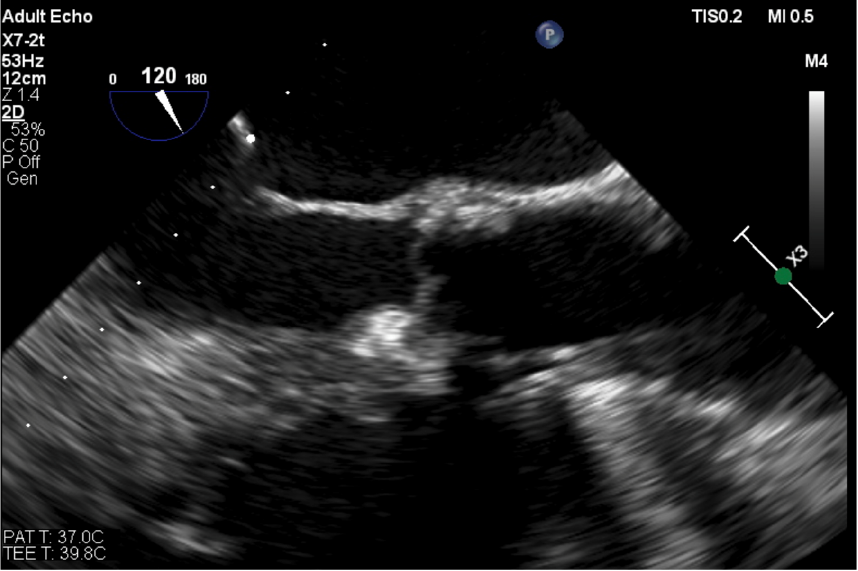
Figure 6. TOE long-axis view of the aortic bioprosthesis poorly visible on X-ray—distal disc of the occluder visualized while being implanted in the PVL located at the right coronary sinus. At this point, biplanar views may simultaneously visualize the position of the plug and ensure the unaffected mobility of the prosthetic discs. See Figure 7A,B.